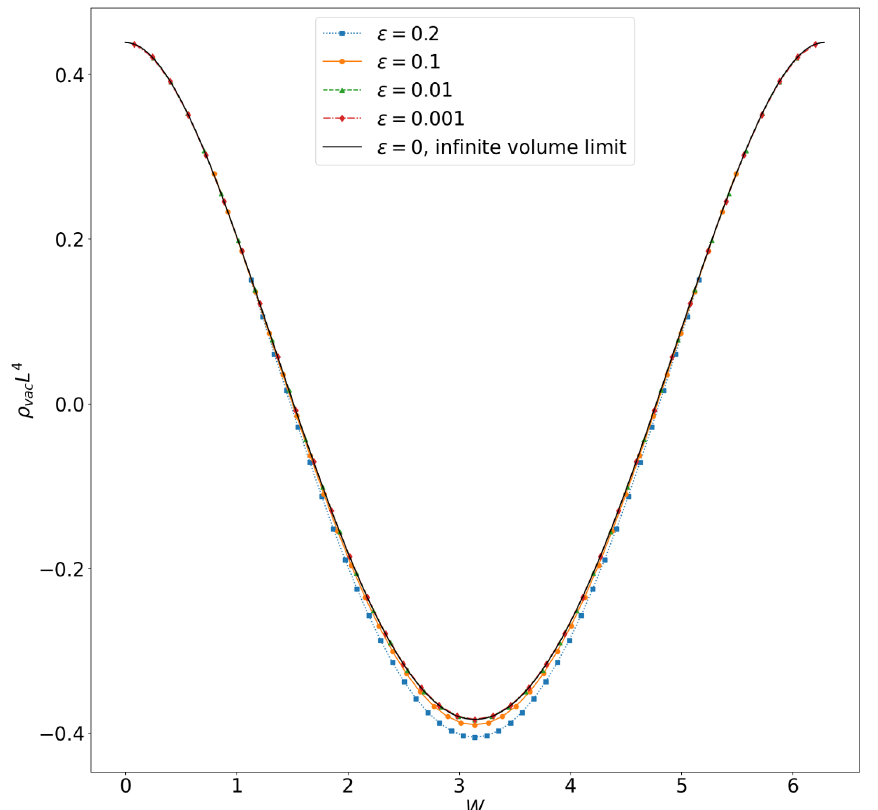
Figure 4 . The contributions of a single massless fermion to the GPY potential. The numerical evaluation used N = 100000 and N = 500 as the upper limit for the n - and p -sums in equation (4.11). n p Here there are no issues with convergence, as for the Taylor series required for the n = − 1 modes of the boson. The infinite volume limit was calculated from equation